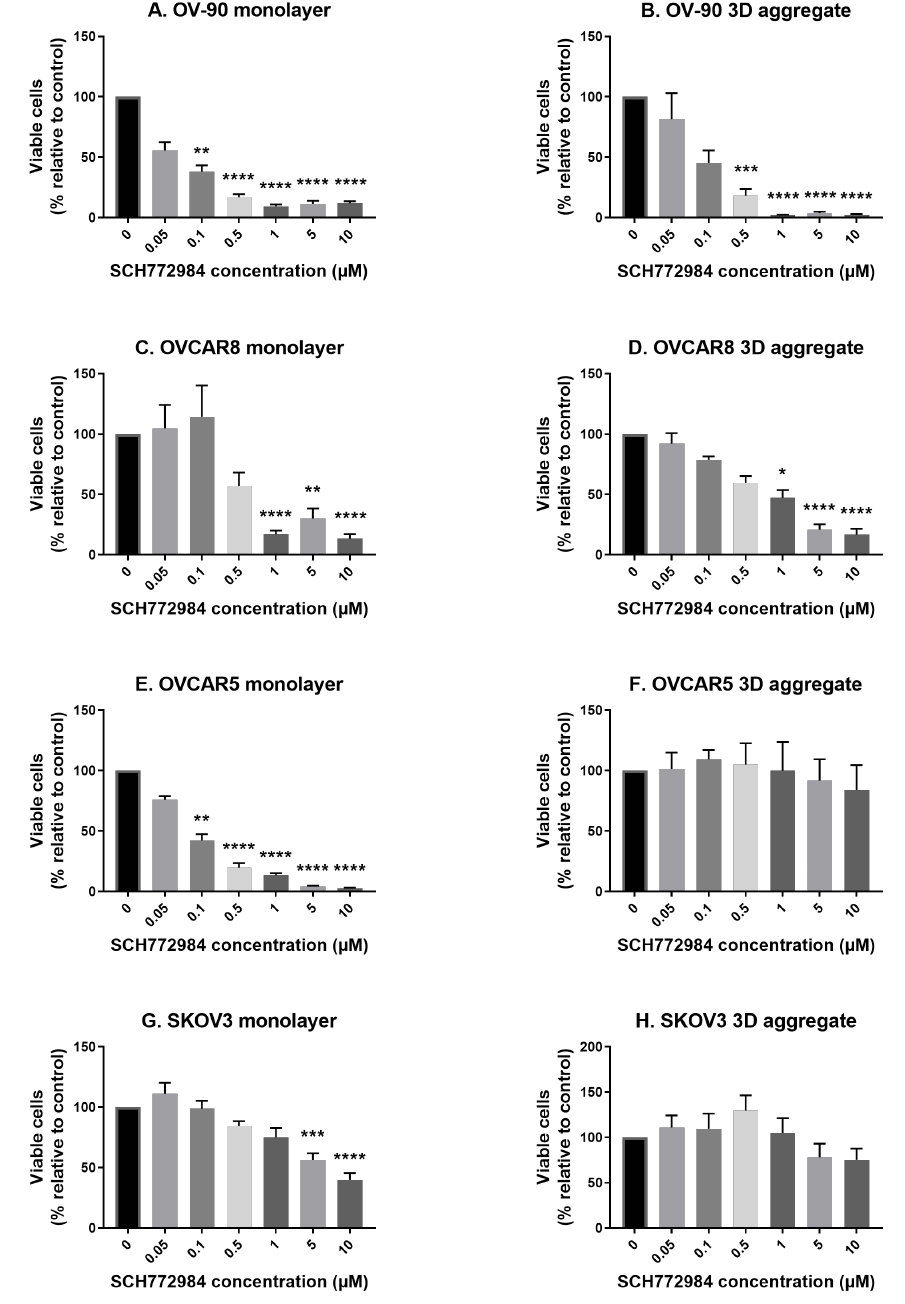
Figure 2. The effect of the extracellular signal-related kinase (ERK) inhibitor SCH772584 on cell viability in OV-90 ( A , B ), OVCAR8 ( C , D ), OVCAR5 ( E , F ) and SKOV3 ( G , H ) monolayer and aggregate cultures. Cell viability was significantly reduced, relative to the control, at concentrations of 0.1 µ M (OV-90 and OVCAR5 monolayers), 0.5 µ M (OV-90 aggregates), 1 µ M (OVCAR8 monolayers and aggregates) and 5 µ M (SKOV3 monolayers) and above. There was no significant effect on OVCAR5 or SKOV3 aggregates. Cultures were established for 48 h prior to a 72 h exposure to SCH772584 at the concentrations shown. Cell viability was determined by staining cells with trypan blue and conducting a cell count. Data are expressed as mean ± SEM (n = 4). Statistical significance is at p < 0.05 and is in comparison to the control. The statistically significant differences are indicated as p < 0.05 (*), p < 0.01 (**), p < 0.001 (***) and p < 0.0001 (****), as determined by one-way ANOVA with a Dunnett’s multiple comparison test on log transformed